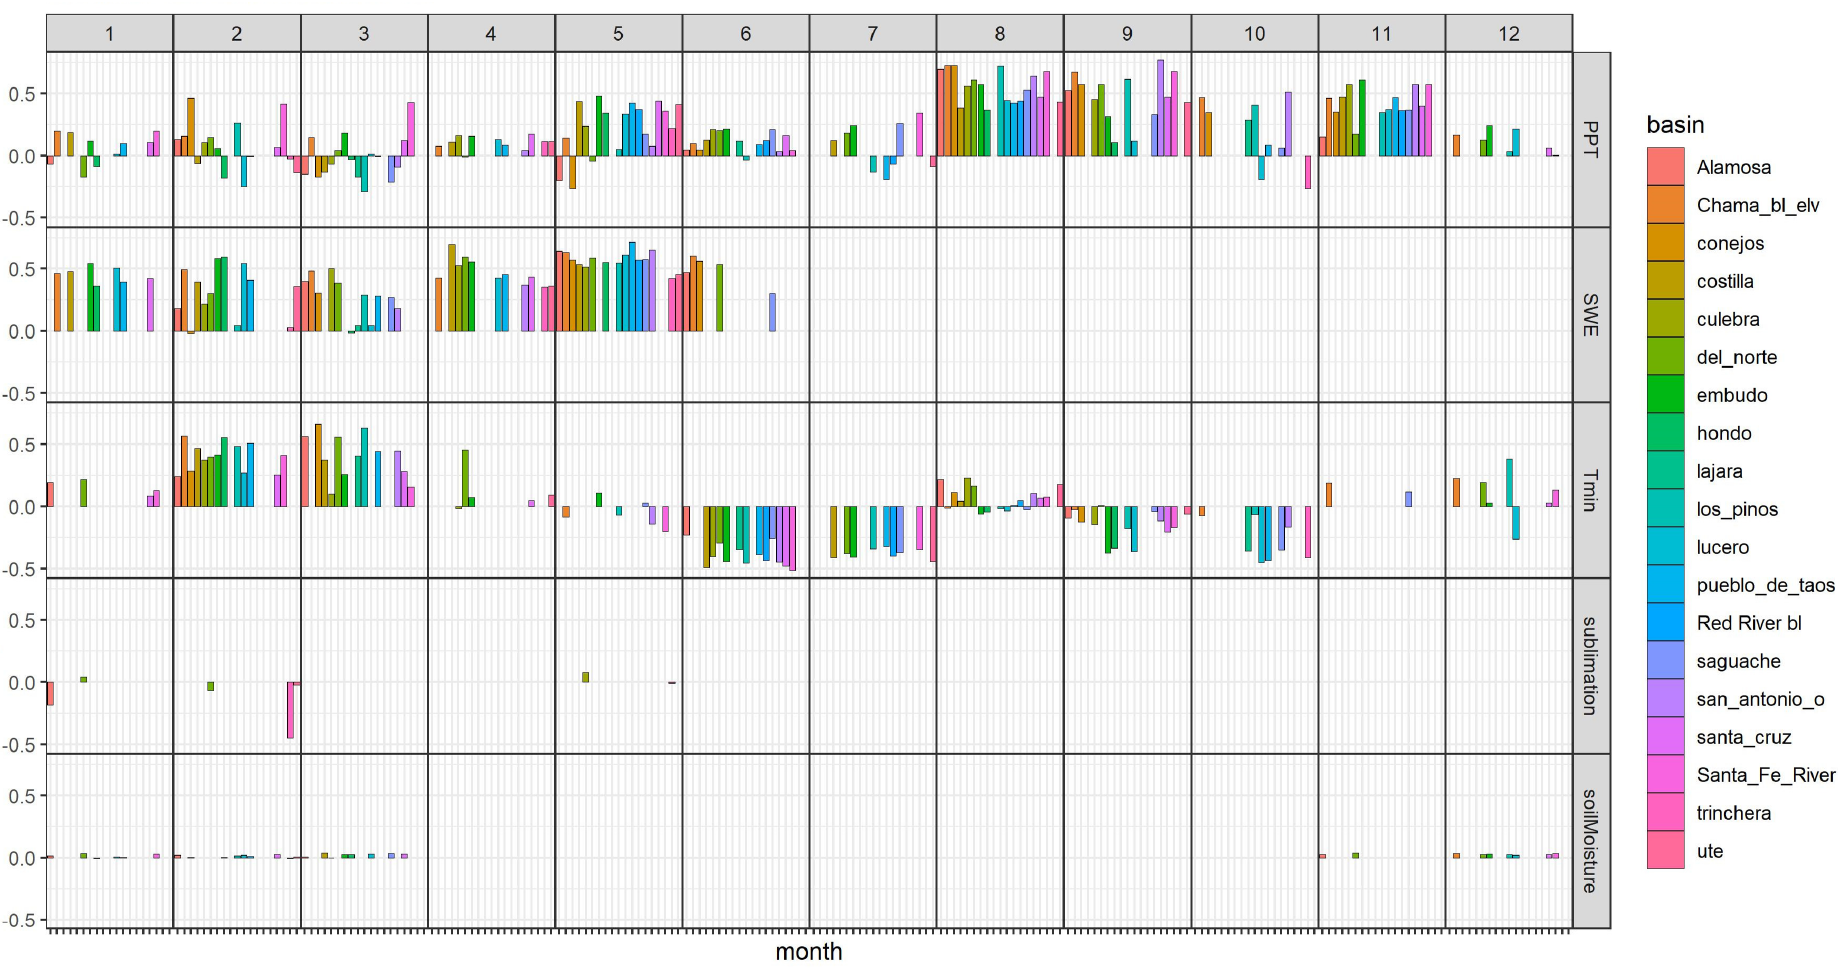
Figure 4. AICc-weighted standardized parameter estimates based on ± 0.4 bivariate correlation cut-off, adjusted for intercept-only model. The priority ranking is: 1. Precipitation, 2. Soil Moisture, 3. Sublimation, 4. SWE, and 5. Minimum